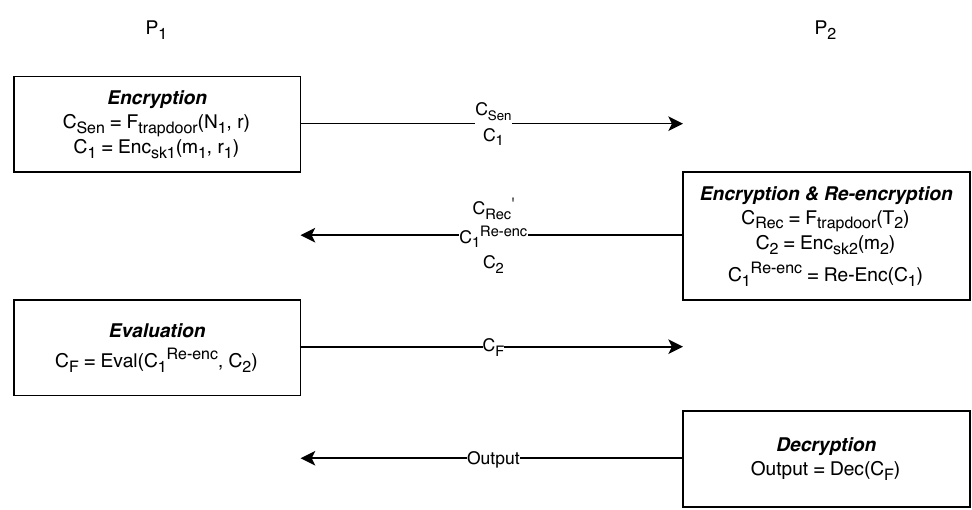
Figure 1. The interaction flow chart of LPCP’s framework. The process of P 1 is on the left side and the process of P 2 is on the right